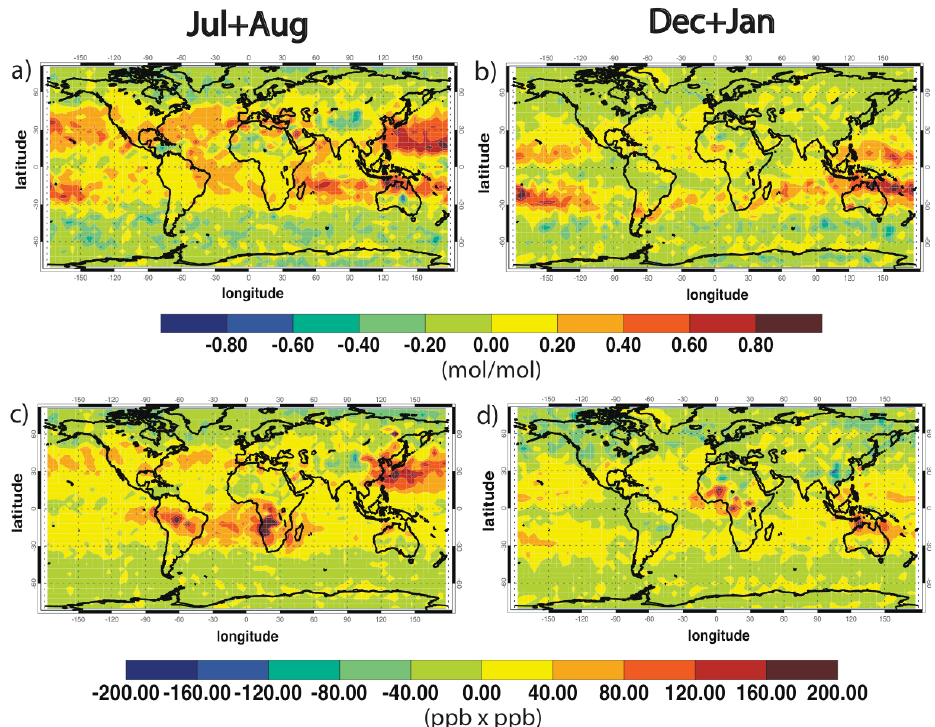
Fig. 4. O 3 -CO slope ( d [O3]/ d [CO]) (a, b) and covariance (c, d) from the 2005–08 800–400hPa TES data for July–August (a, c) and December–January (b, d)